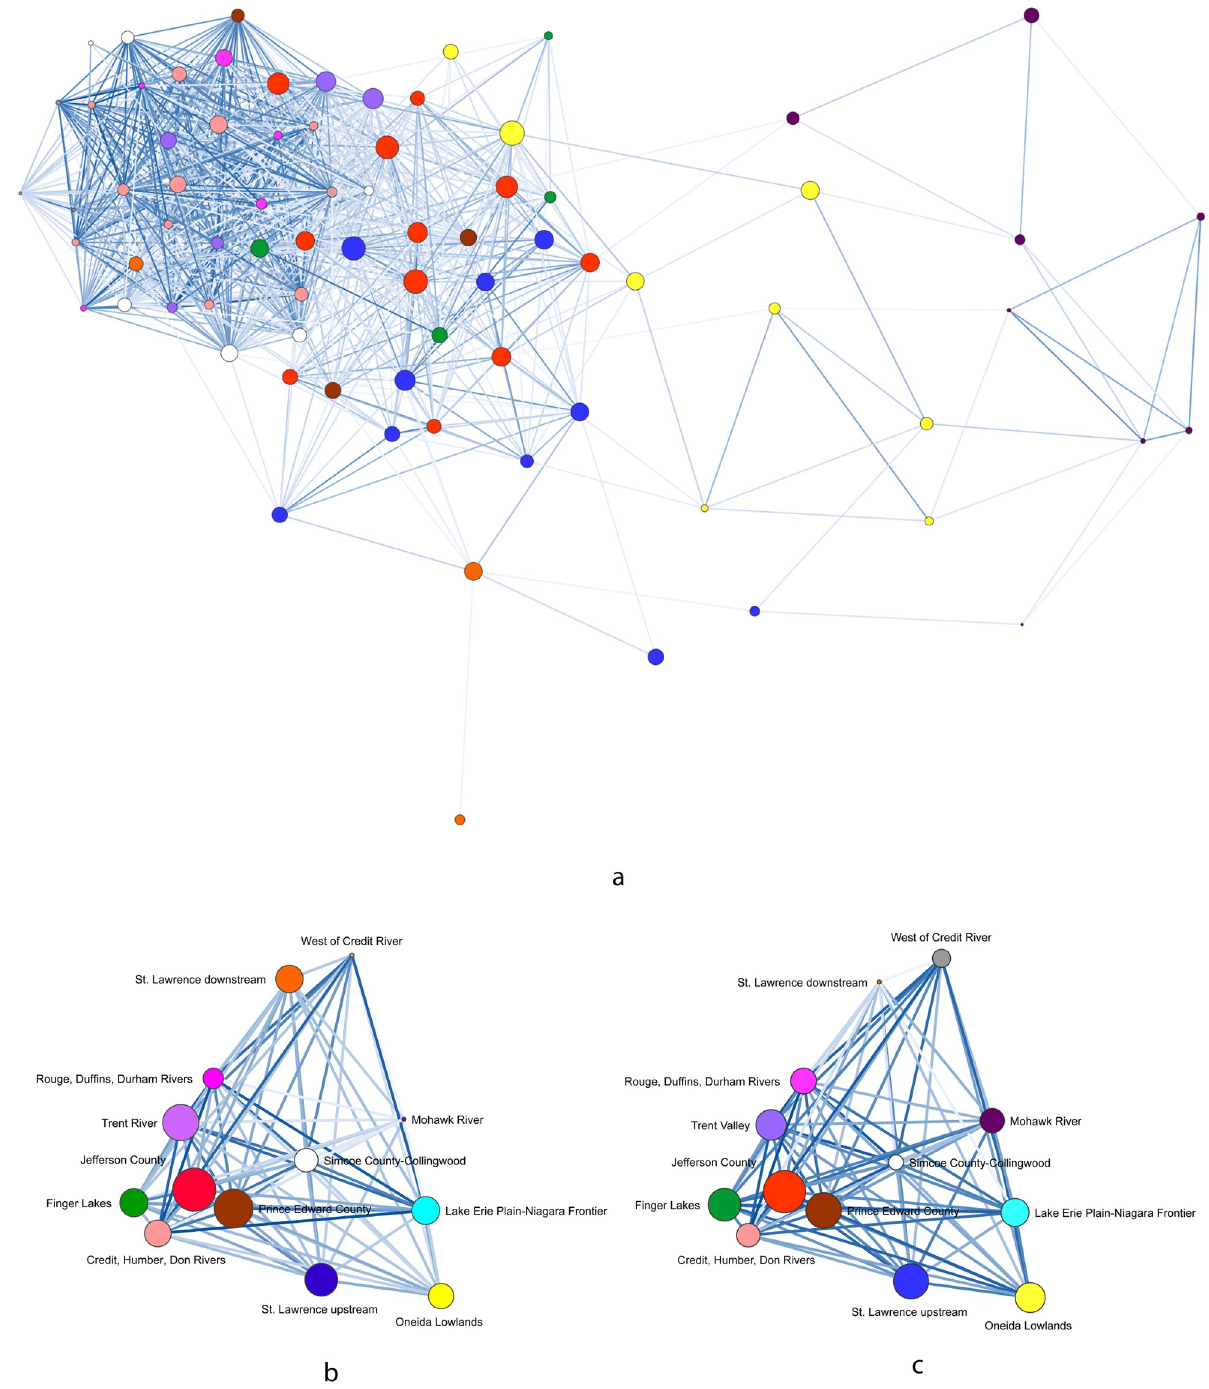
Fig 6. AD 1450–1550 network visualizations. (a) BR site-level network with threshold of � 0.50 and spring embedder layout, (b) weighted BR centroid network with MMDS layout, (c) weighted LCP similarity centroid network with MMDS layout. Node size based on potential brokerage